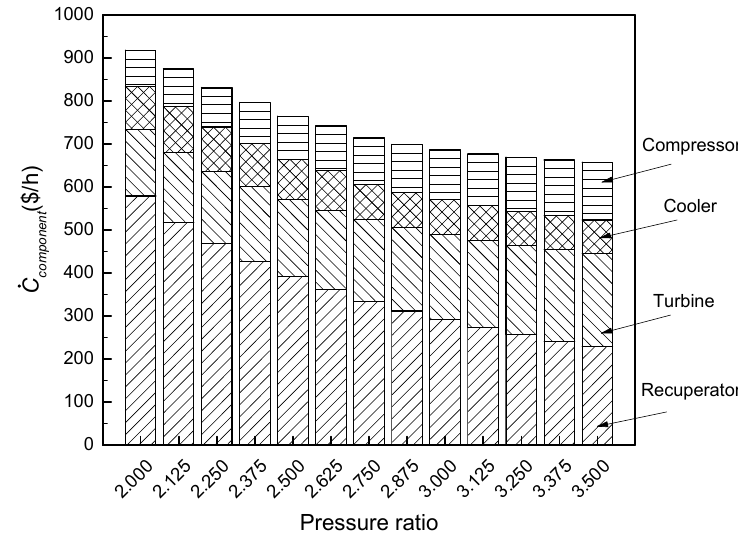
. β on C component with the partial-cooling